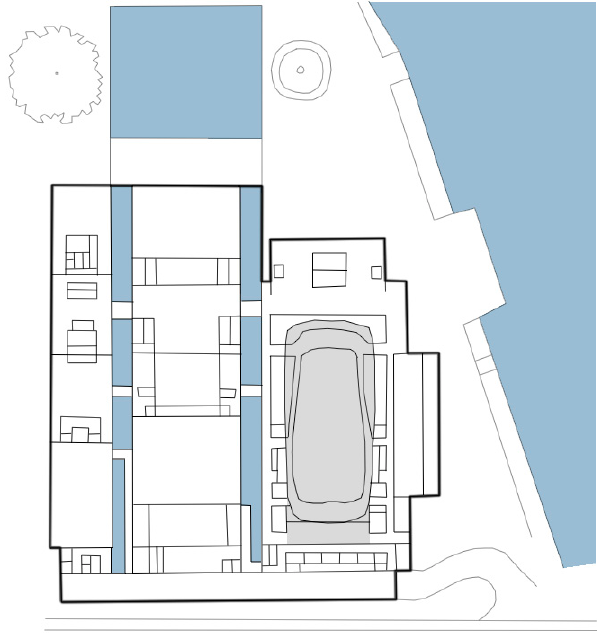
Figure 10. Projection of Kultur- und Kongresszentrum Luzern, graphic processing, based on [29] by E. Latusek.